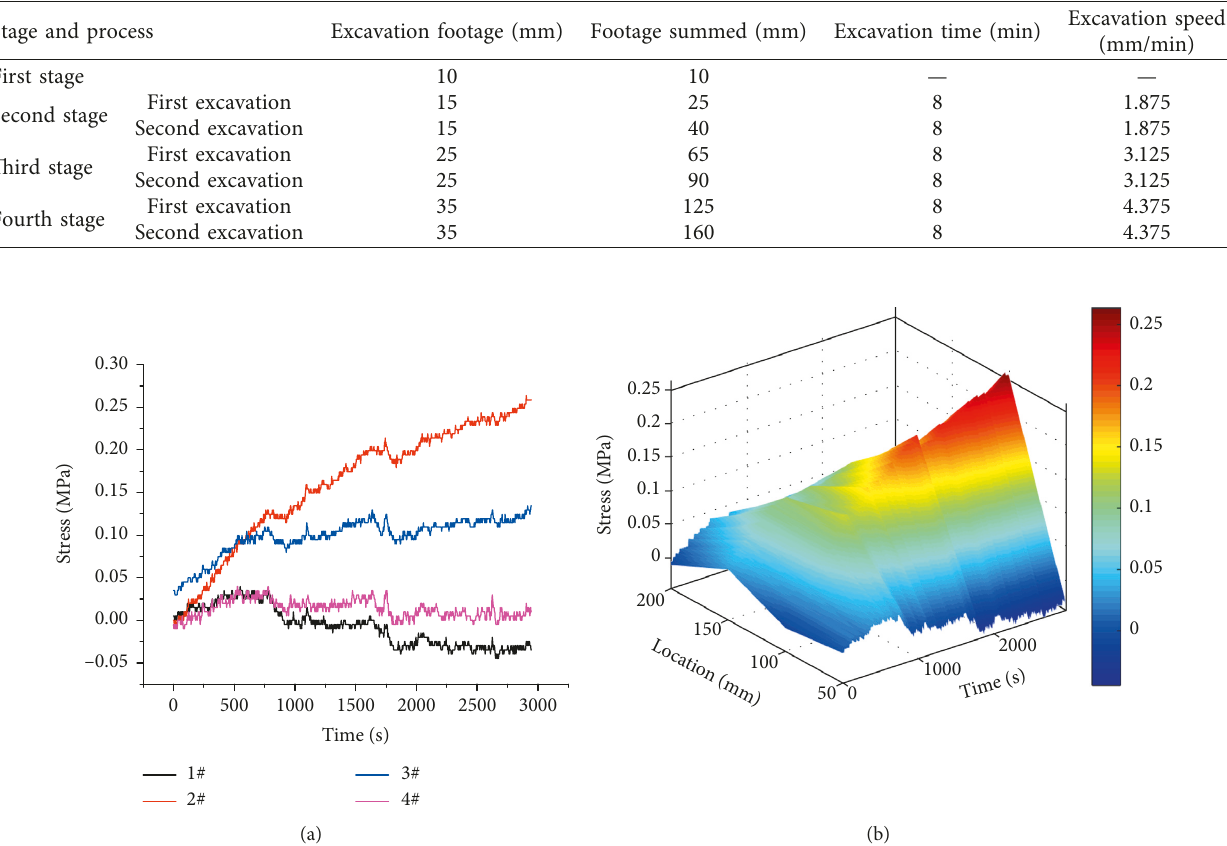
Figure 4: Stress evolution after opening the tunneling hole: (a) stress-time curve of 4 measuring points; (b) diagram of stress distribution in different locations over